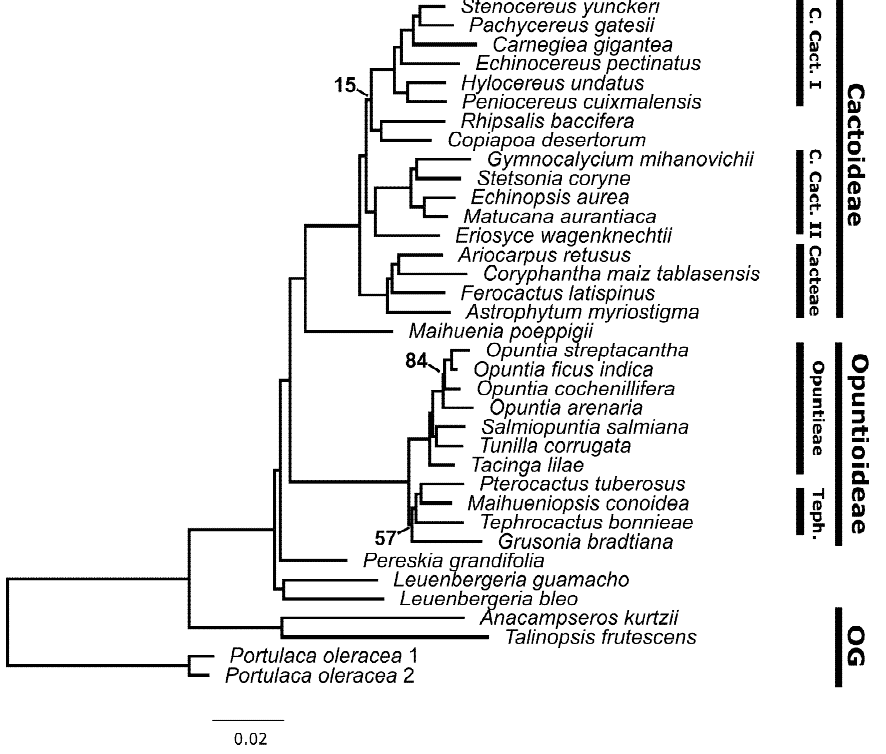
Figure 3. RAxML best-scoring ML tree of the concatenated database of the two probe sets. All nodes have ≥95% support value bootstrap unless noted. OG: Outgroups; Teph.: Tephrocacteae; C. Cact.: Core Cactoideae.